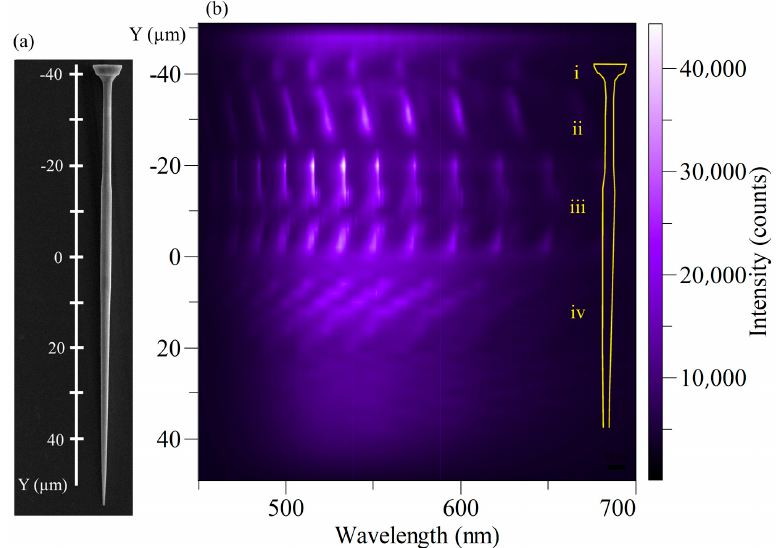
7 Figure 7. ( a ) SEM image of a long nail ending in a hexagonal head with the Y-axis scale used to record the µ -PL map in ( b ). The µ -PL map shows the variation along the stem of the nail in terms of the intensity and wavelength shifts.